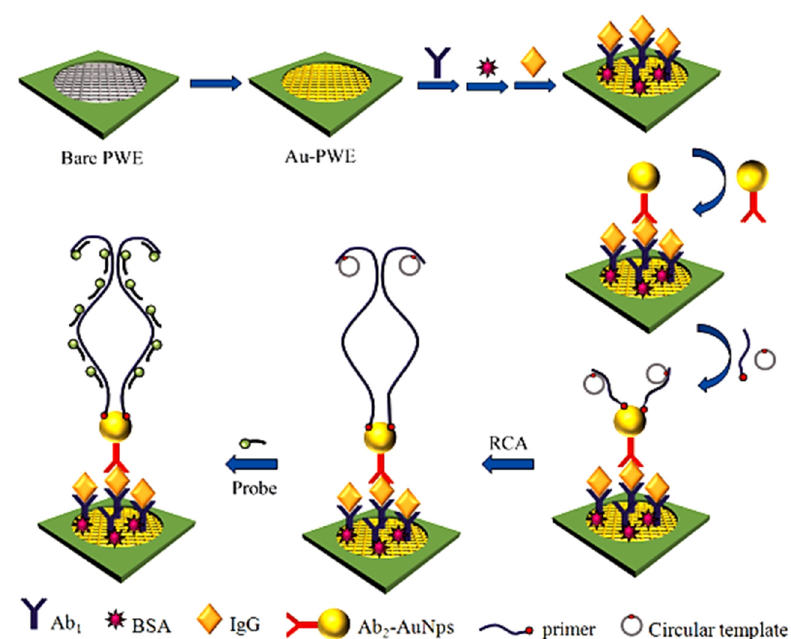
Figure 15. The schematic presentation of the fabrication procedures for the paper-based electrochemiluminescence origami device (PECLOD), (IgG—human immunoglobulin G protein; Ab—capture antibodies of IgG; BSA—bovine serum albumin; Ab 2 —monoclonal antihuman IgG antibodies; Au Nps—gold nanoparticles; primer—primer DNA; circular template—circular template DNA; probe —carbon dots-DNA probe; RCA—rolling circle amplification). Reprinted from [ 342 ] . Copyright 2015, with permission from Elsevier B.V.